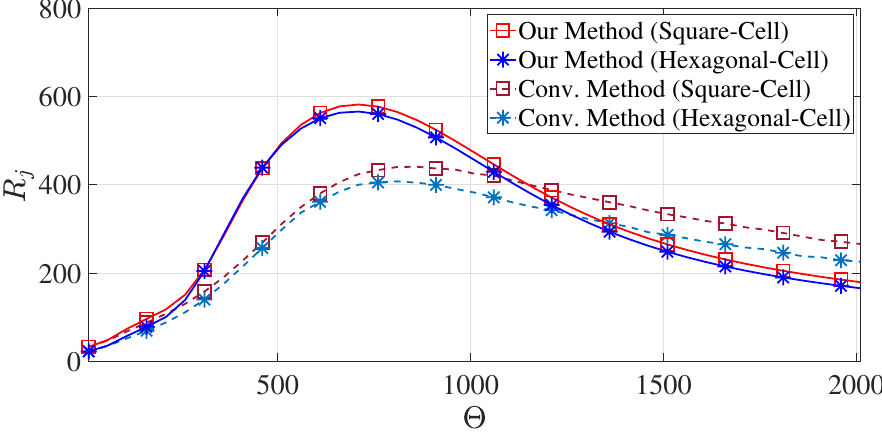
Figure 6. The total channel capacities with respect to Θ for both square and hexagonal cells with the identical cell area 2 Θ 2